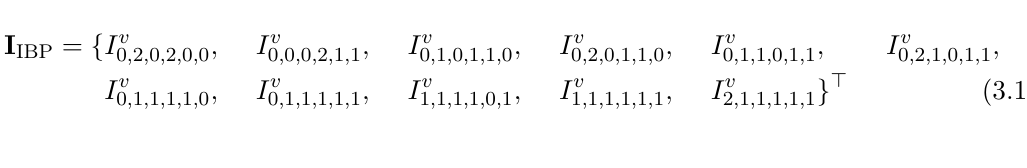
Figure 3 . Plot of the ε 0 correction to the I v numerically with the FIESTA package